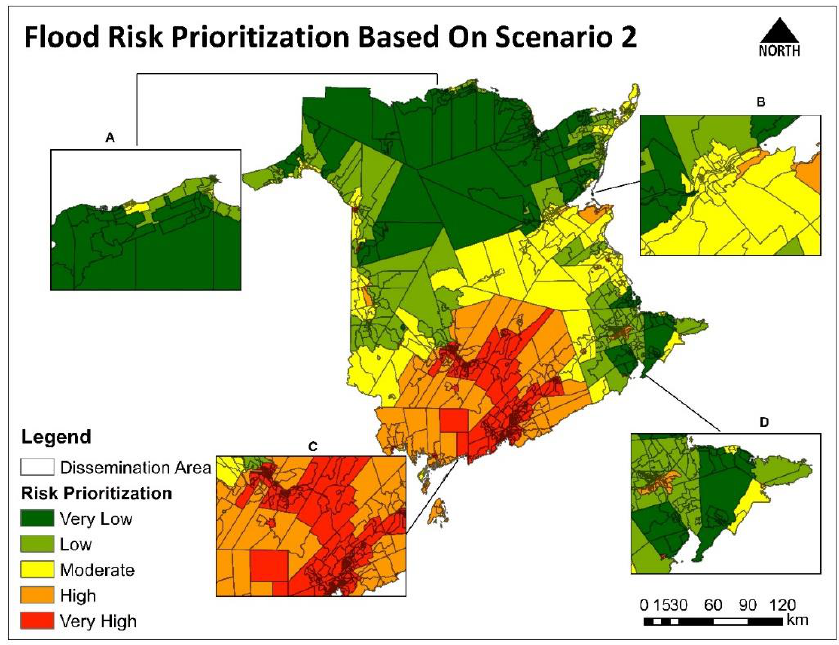
Figure 6. Flood risk prioritization based on scenario 2 using zonal statistics.